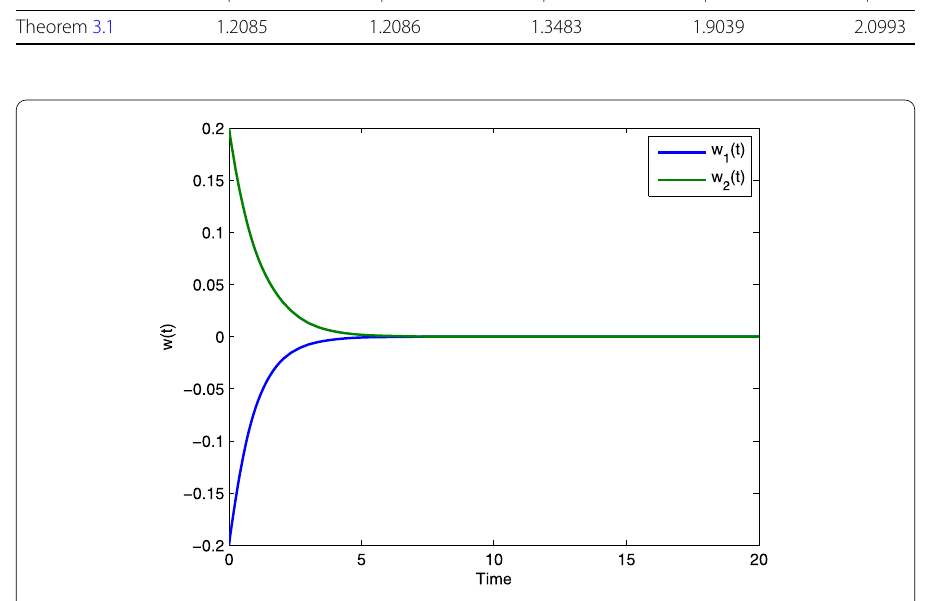
Figure 1 The trajectories of w 1 ( t ) and w 2 ( t ) with u ( t ) = 0 in Example